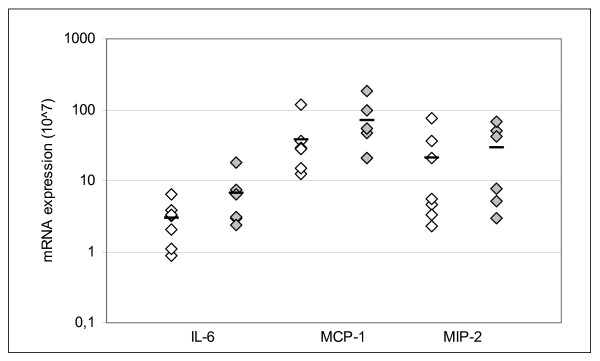
mRNA expression of inflammatory cytokines in liver from pups at PND 2. Expression of mRNA is normalized to 18S rRNA. Empty squares: Controls; filled squares: DEP. Horisontal line: mean value. Levels of mRNA of IL-6, MCP-1, and MIP-2 were normalized to the 18S levels. n = 6–7.